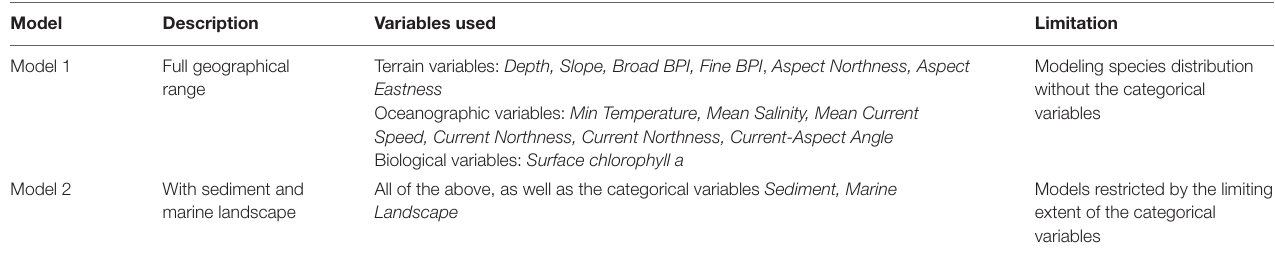
TABLE 2 | The two models run in Maxent, with their used variables and